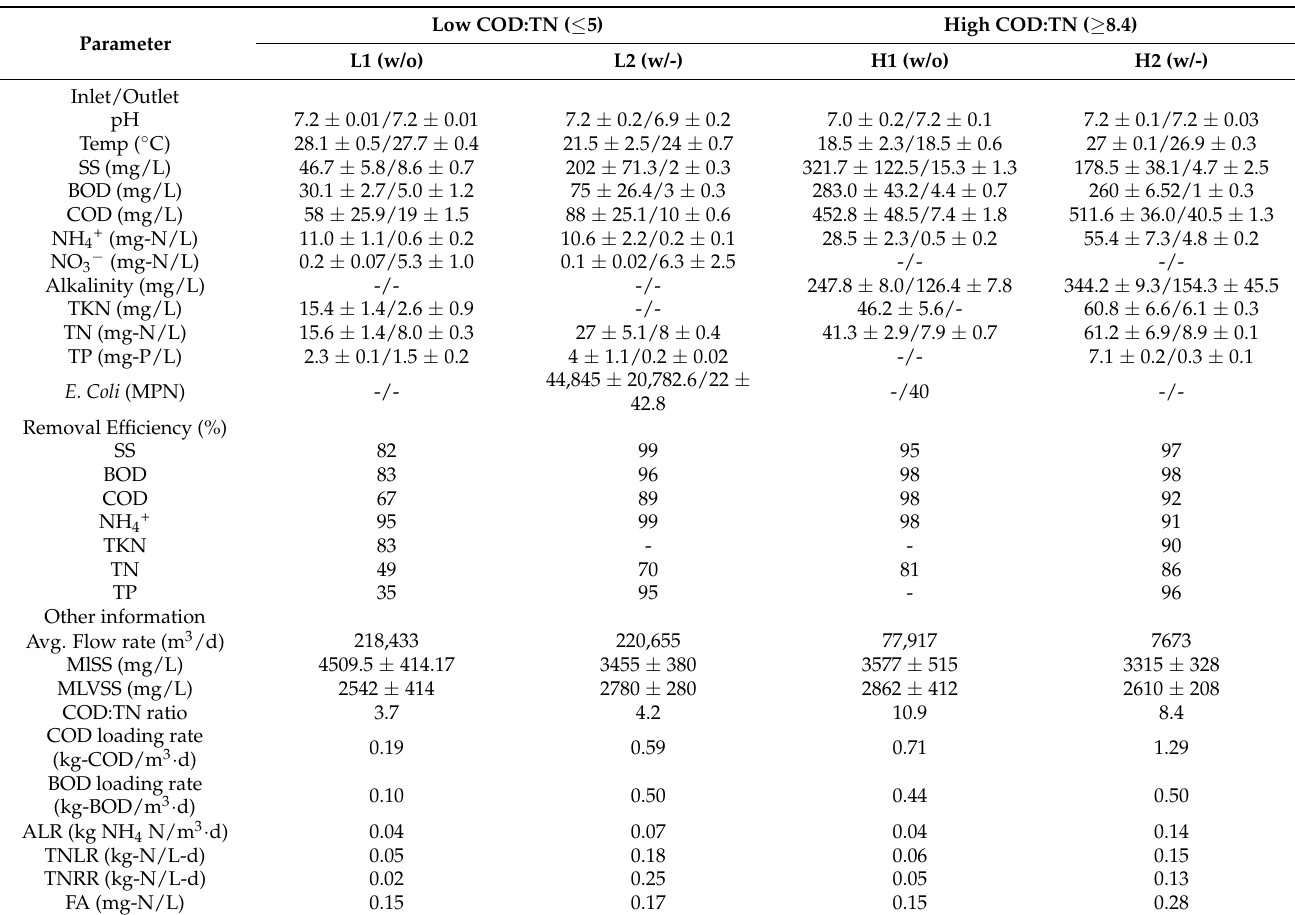
Table 2. Comparing the average physical and chemical characteristics of wastewater quality in full-scale pre-anoxic zone w/- and w/o anaerobic systems by low and high COD:TN